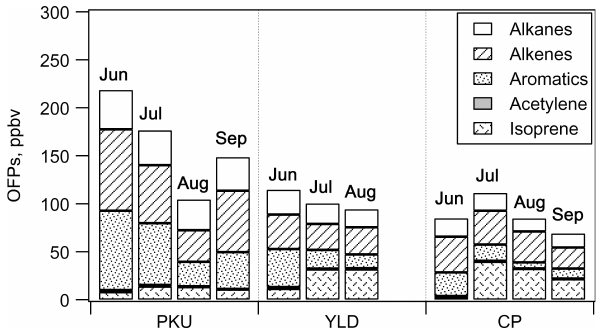
Fig. 6. Average OFPs of measured alkanes, alkenes, aromatics, acetylene, and isoprene at PKU, YLD and CP site from June to